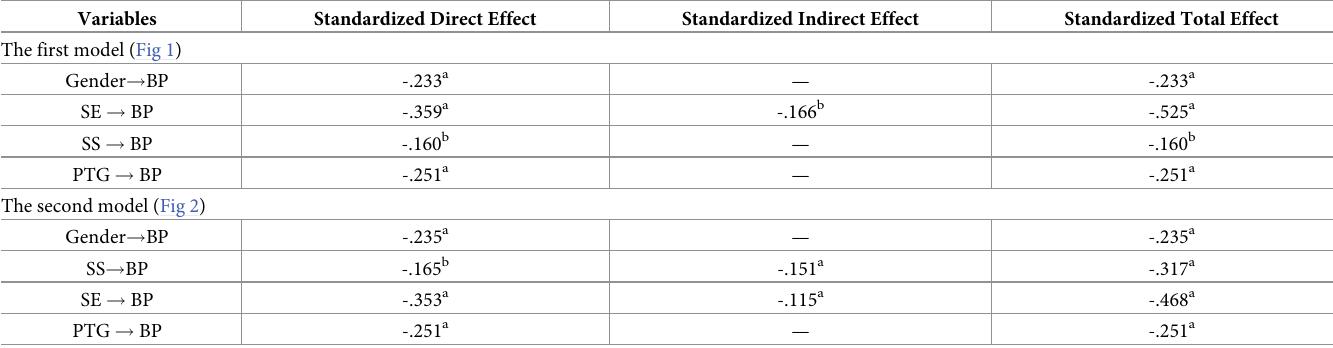
Table 3. Direct, indirect and total effects of variables in the first and second model (N = 160).